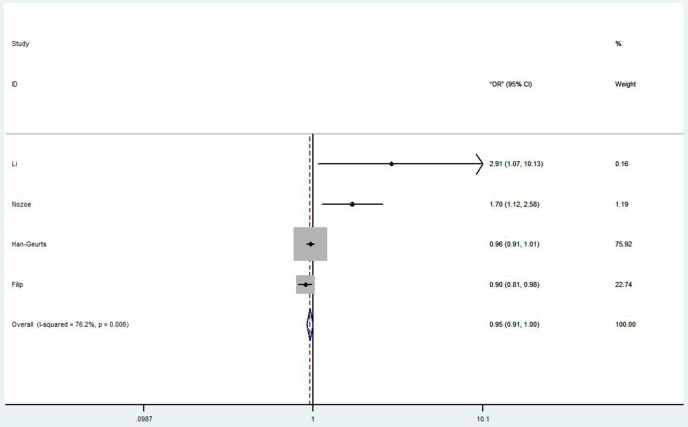
Forest plot of the HR assessing the correlation between the PNI and complications in EC patients. HR, hazard ratio; EC, esophageal cancer; PNI, prognostic nutritional index.